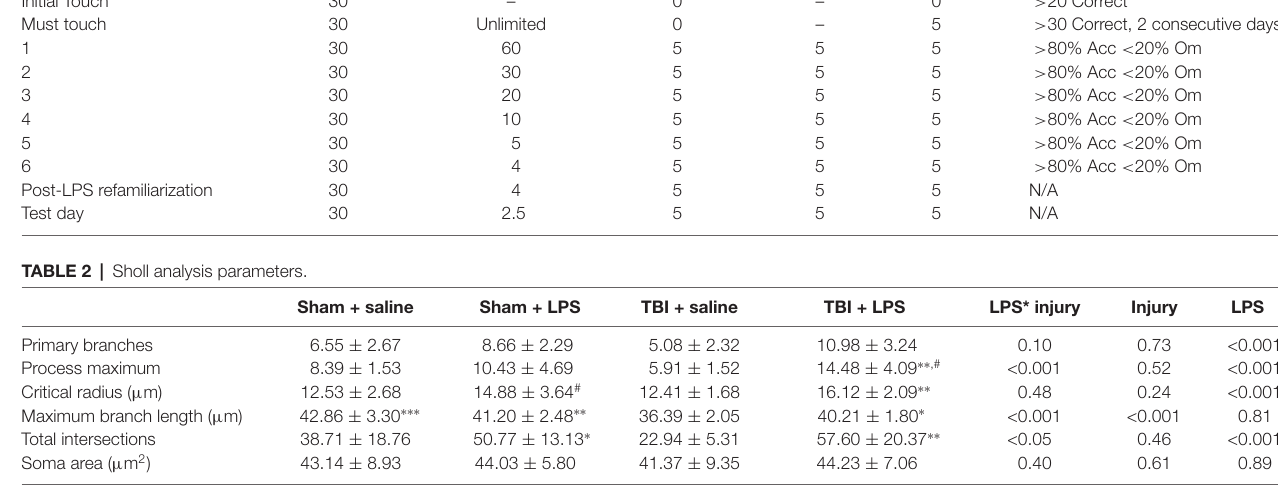
TABLE 1 | Parameters used throughout training and testing on the 5-choice serial reaction time task (5-CSRTT). Level